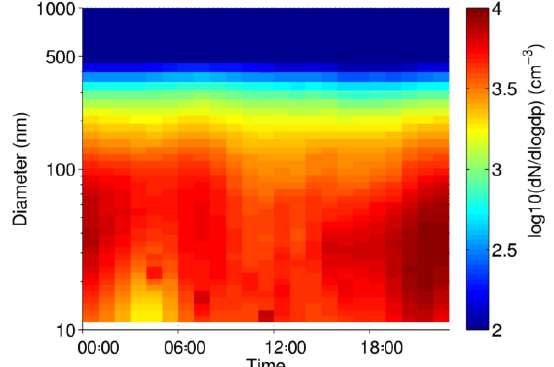
Figure 5. Mean diurnal cycle of the particle number concentration by